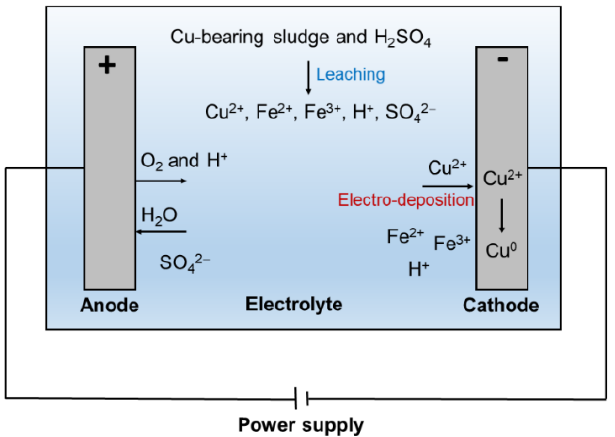
Figure 3. Chemistry of integrated acid leaching and electrolytic deposition.